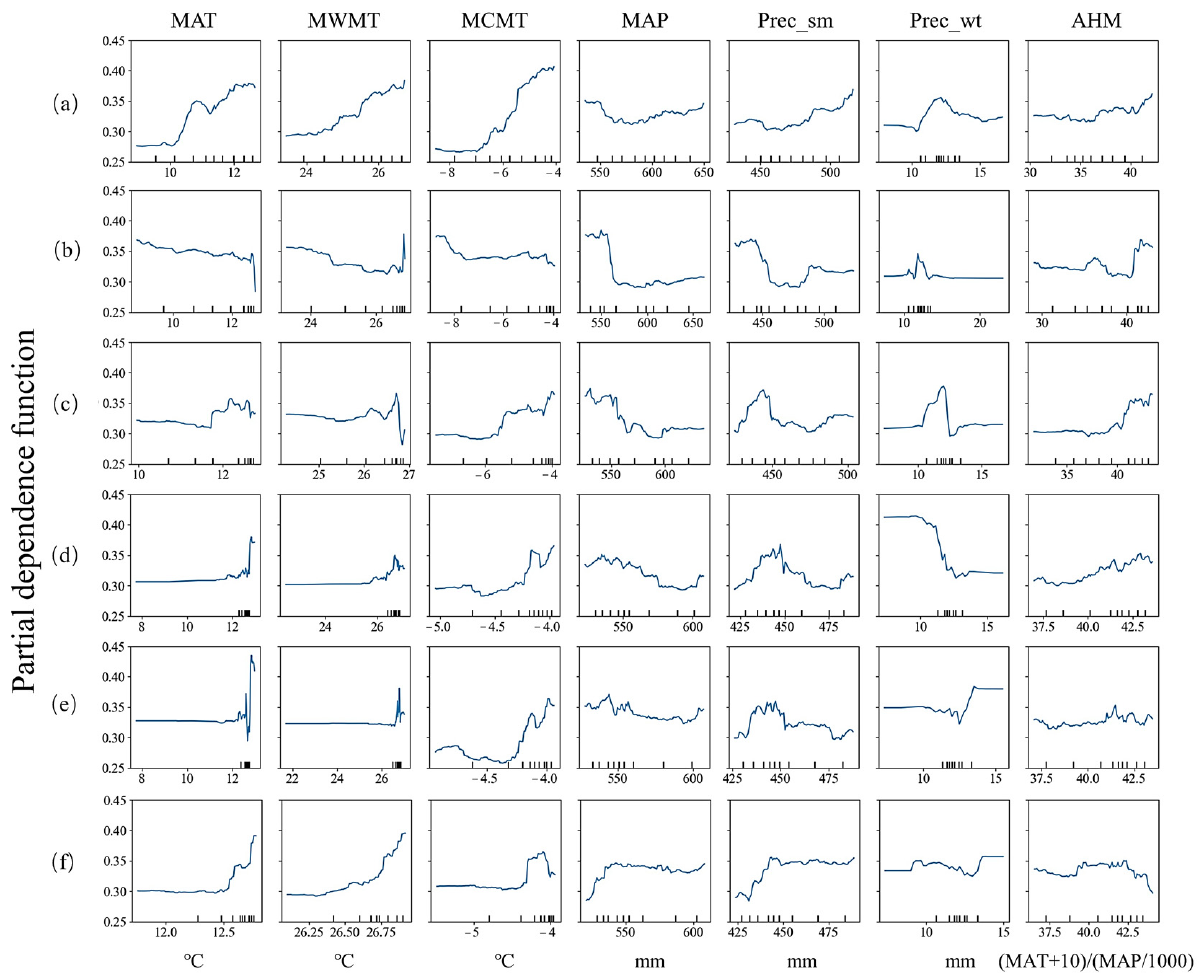
Figure 5. Partial dependence plots of important impact factors for six main tree species. ( a ) Platycladus orientalis (Linn.) Franco; ( b ) Pinus tabulaeformis Carr.; ( c ) Robinia pseudoacacia Linn.; ( d ) Sophora japonica Linn.; ( e ) Salix matsudana Koidz.; ( f ) Populus tomentosa Carr.